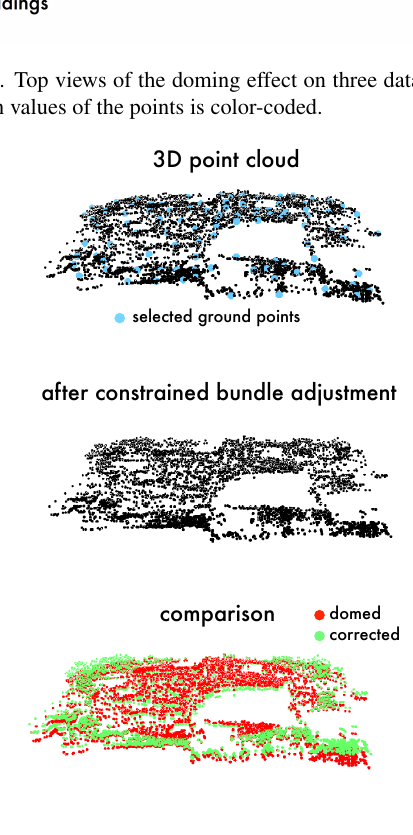
Figure 7. Sample results on the village dataset. T OP : the sparse data given in input, selected points on the ground X i , i ∈ U are denoted as blue dots. M IDDLE : constrained Bundle Adjustment succeeds in mitigating the doming effect. B OTTOM : comparison between the input and the output point